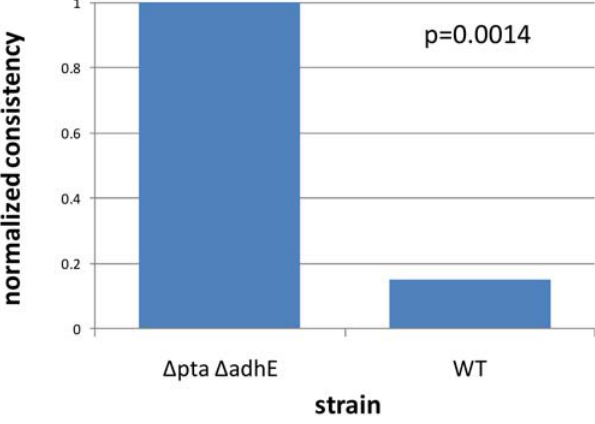
Figure 3. Glycerol-evolved strain normalized consistency scores. Normalized consistency scores are computed directly from the inconsistency scores, as described in the text. A higher normalized consistency score indicates that the gene expression data is relatively more consistent with the RMF. Thus, here the gene expression data from the glycerol-evolved strains are more consistent with highly efficient growth on each of the carbon sources tested. The p values, determined by permutation testing, are less than 0.01 in all cases here.